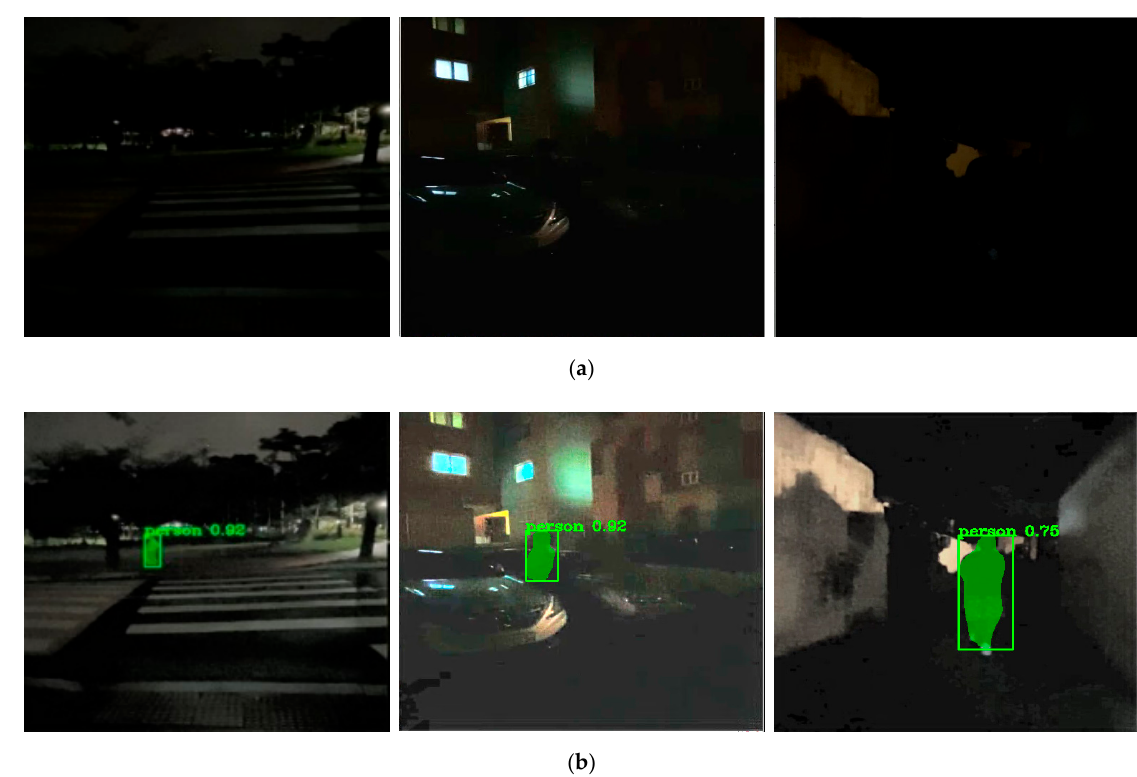
Figure 18. Detection of Mask R-CNN: ( a ) detection of original images and ( b ) detection of proposed results.